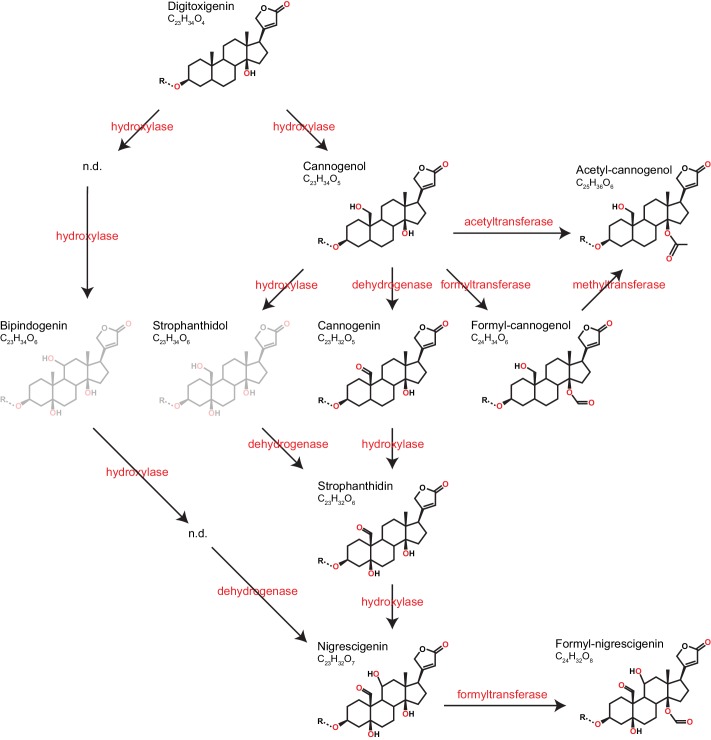
Predicted pathways of cardenolide genin modification in Erysimum.Pathways are linearized for simplicity but more likely form a complex network. Genin diversity likely originates from digitoxigenin, which is transformed into more stucturally complex cardenolides by hydroxylases, dehydrogenases, and formyl-, methyl-, or acetyltransferases. Acetyl-cannogenol could be derived directly from cannogenol or from formyl-cannogenol, with the frequent co-occurrence of acetyl-cannogenol and formyl-cannogenol in leaf extracts suggesting the latter. According to their exact mass, frequently detected dihydroxy-digitoxigenin compounds (C23H34O6) could be either bipindogenin or strophanthidol (grayed out). While bipindogenin cardenolides have commonly been reported for Erysimum species in the literature, their structure would require additional intermediates that have not been detected (n.d.). Thus, strophanthidol appears to be the more likely isomer to occur in Erysimum. All cardenolide genins are further modified by glycosylation at a conserved position in the molecule (R). Note that all structures are putative, and particularly formyl- and acetyl-modifications could be attached to any free OH-group.